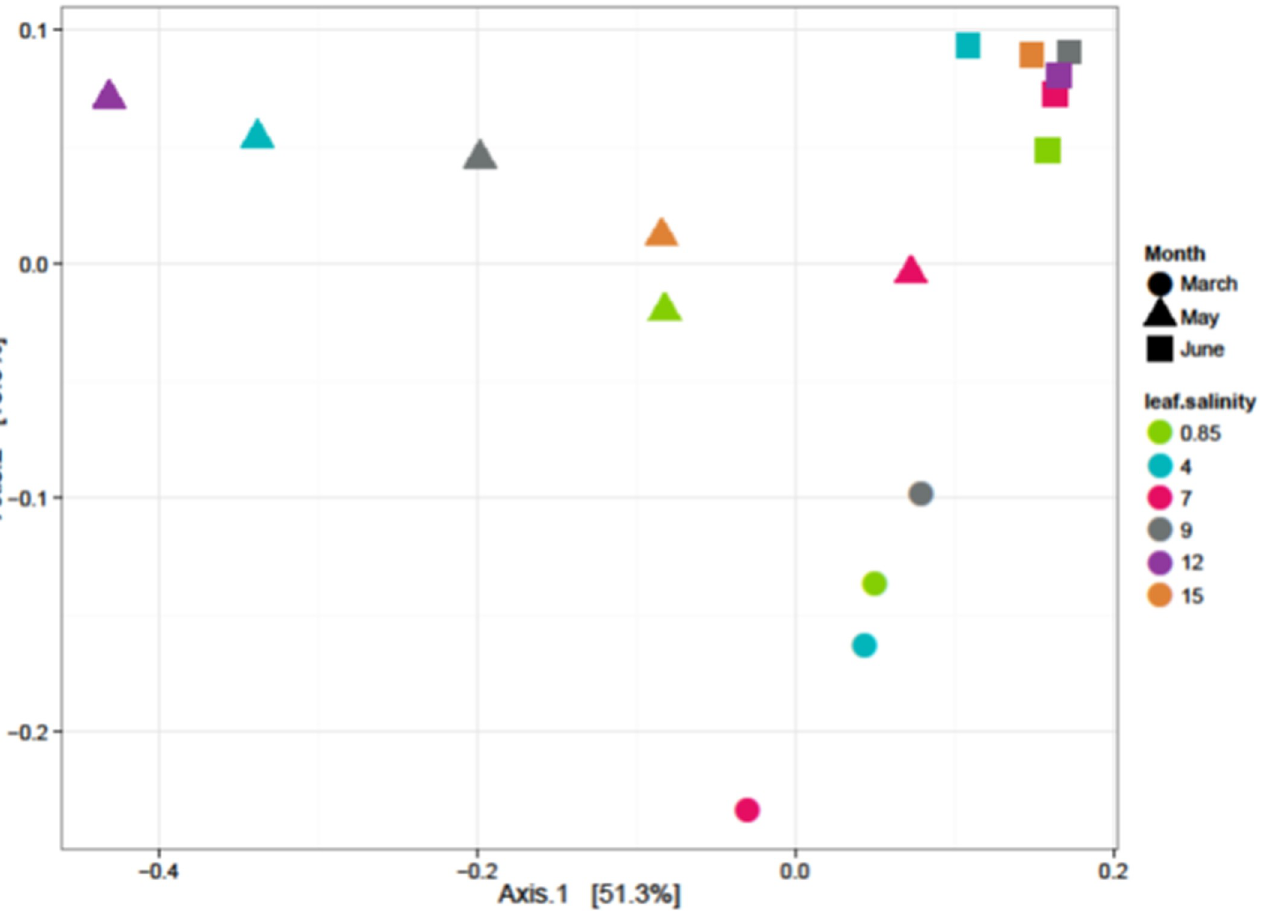
Fig 1. Weighted ordination in the phyllosphere: Dimensional reduction of the Bray-Curtis distance between microbiome samples, using the PCoA ordination